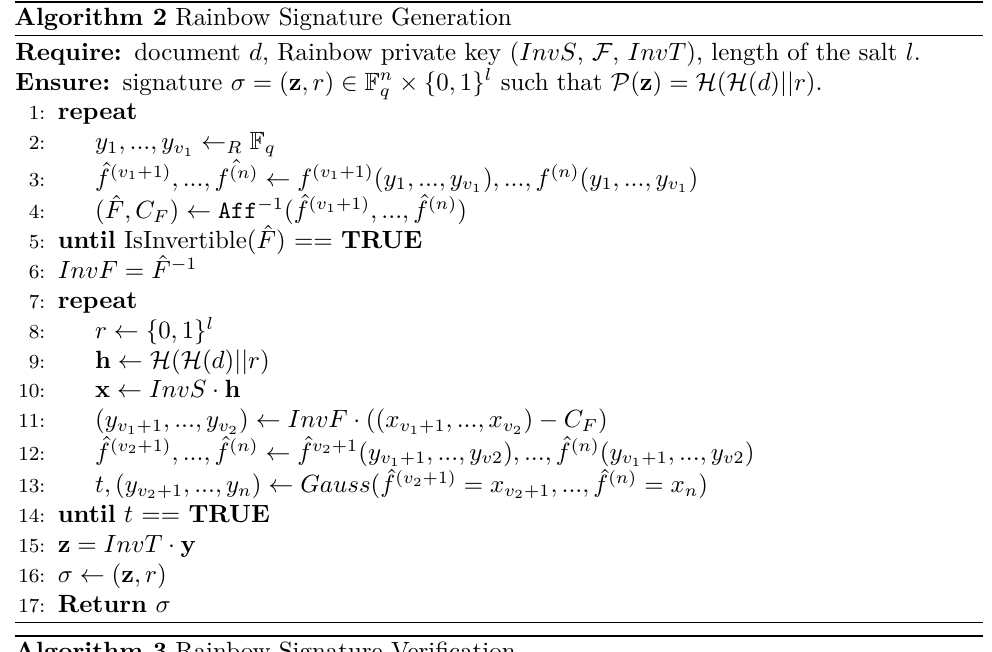
Algorithm 2 Rainbow Signature Generation